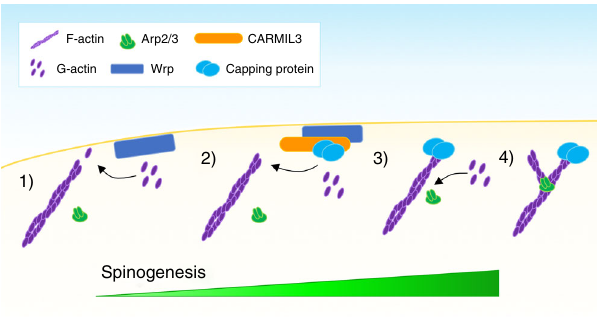
Fig. 8 Schematic of proposed CARMIL3 function during synapse development. (1) In the absence of CARMIL3 and capping protein, monomeric (G-actin) is preferentially added to the barbed ( + ) ends of fi lamentous actin (F-actin). (2) CARMIL3 bound to capping protein is recruited to the membrane of developing protrusions through its interaction with Wrp. (3) Capping protein binds to the barbed ends of actin fi laments, preventing the addition of G-actin. (4) G-actin is now primed for nucleation by the Arp2/3 complex, which shifts the actin dynamics of the developing synapse from largely linear actin to a dense, branched actin network required for synaptic